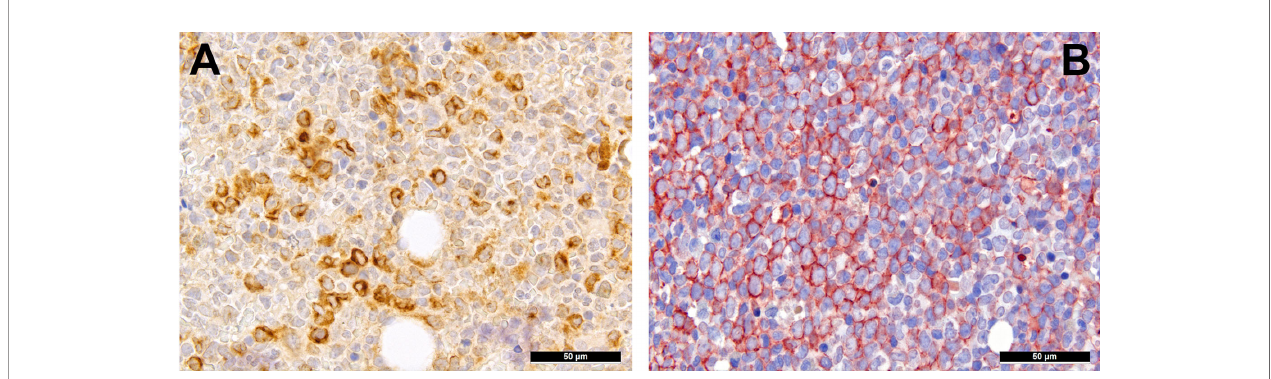
FIGURE 2 | Expression of hyaluronic acid binding proteins in AML. (A) Diffuse expression of RHAMM in AML cells (immunohistochemistry, 400x); (B) Diffuse expression of CD44v6 in AML cells (immunohistochemistry,